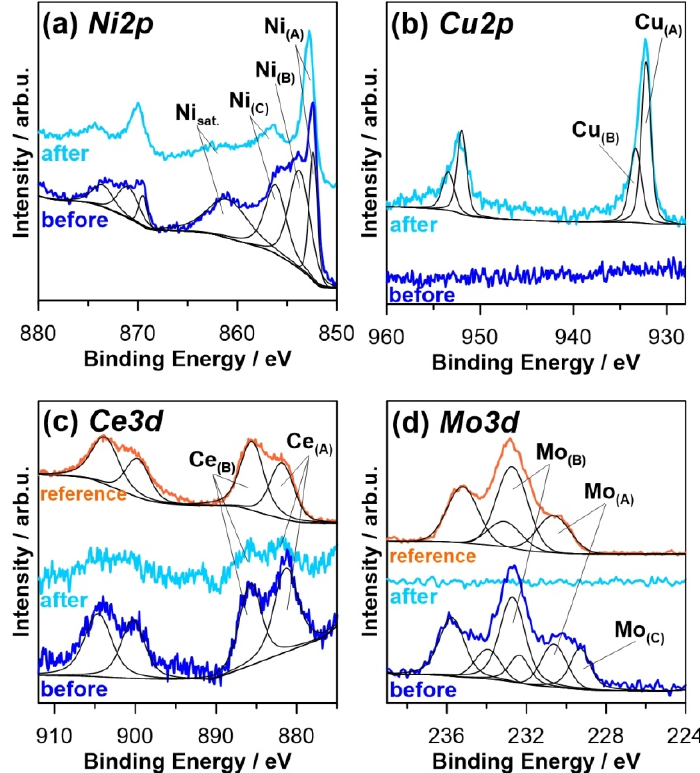
Figure 10. High-resolution XPS spectra recorded for composite Ni coating in ( a ) Ni2p, ( b ) Cu2p, ( c ) Ce3d, and ( d ) Mo3d peak binding energy range, before and after the exposure to 0.05 M NaCl. The chemistry of synthesized cerium molybdenum oxide hydrate powder used for electrodeposition is also shown in ( c ) Ce3d and ( d ) Mo3d spectra (“reference” spectra).